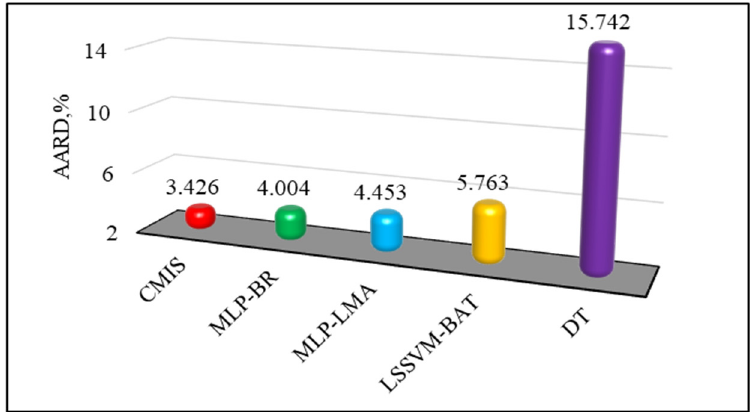
Figure 14. Comparison among AARD (%) of different models for prediction of viscosity of ILs based on Model (III).